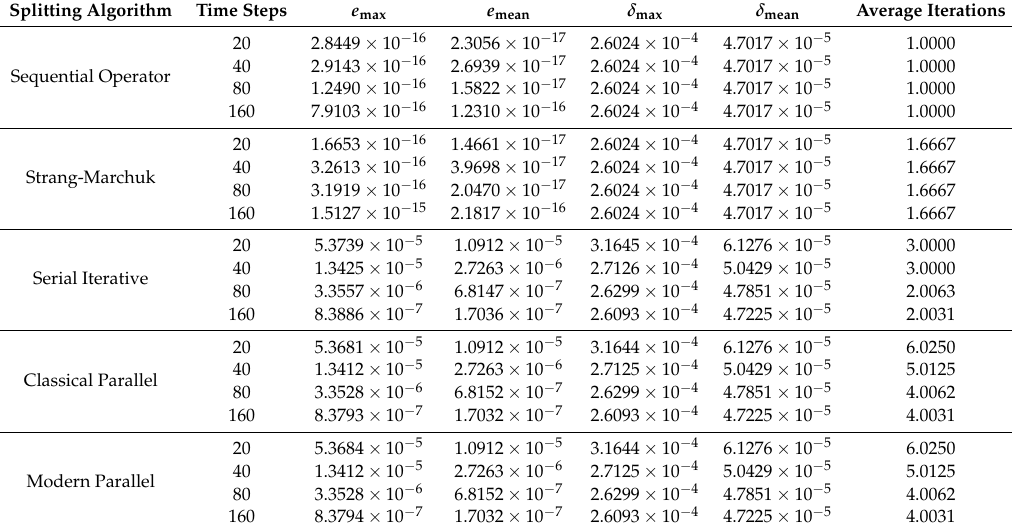
Table 4. Diffusion problem. Results of the directional decomposition using the fourth order scheme for the spatial discretization, with 10 subintervals in each dimension and different number of temporal